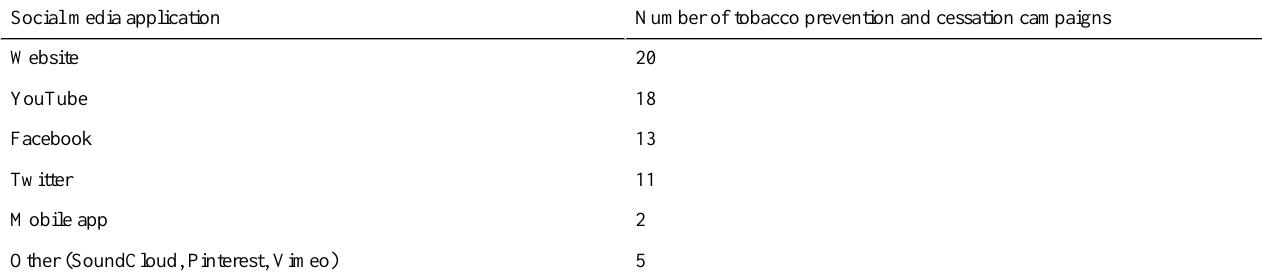
Table 3. Social media applications used by 21 smoking cessation and prevention campaigns for Indigenous